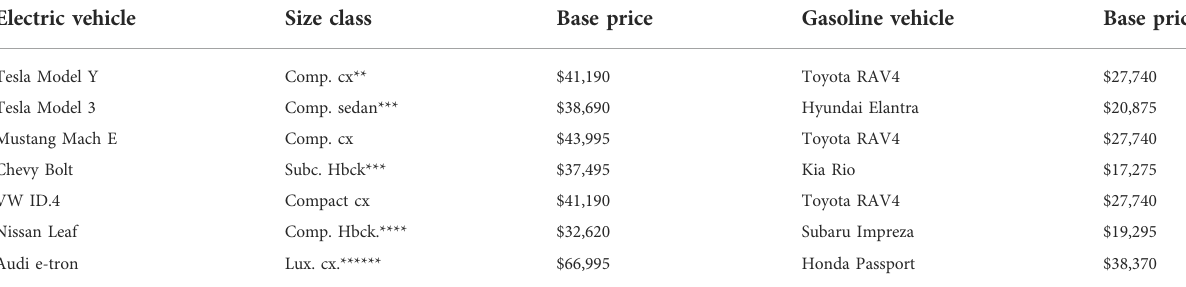
TABLE 2 2021 base price of top-selling EVs versus base-price of highly rated gasoline-powered vehicle in the same size class, using MSRPs* (White, 2022). Electric